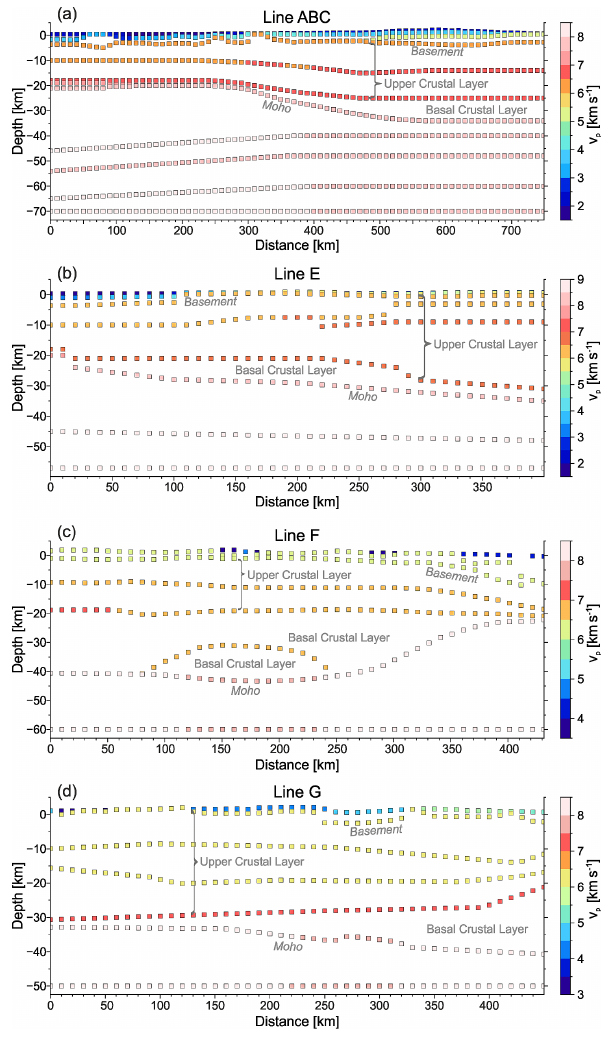
Figure B1. P wave velocity structure along the KRISP refraction seismic profiles (e.g. Khan et al., 1999); the plotted velocities repre- sent mean values for the depth interval below the respective vertex; for locations of the profiles refer to Figs. 1b and 4; (a) profile ABC; (b) profile E; (c) profile F; (d) profile G.